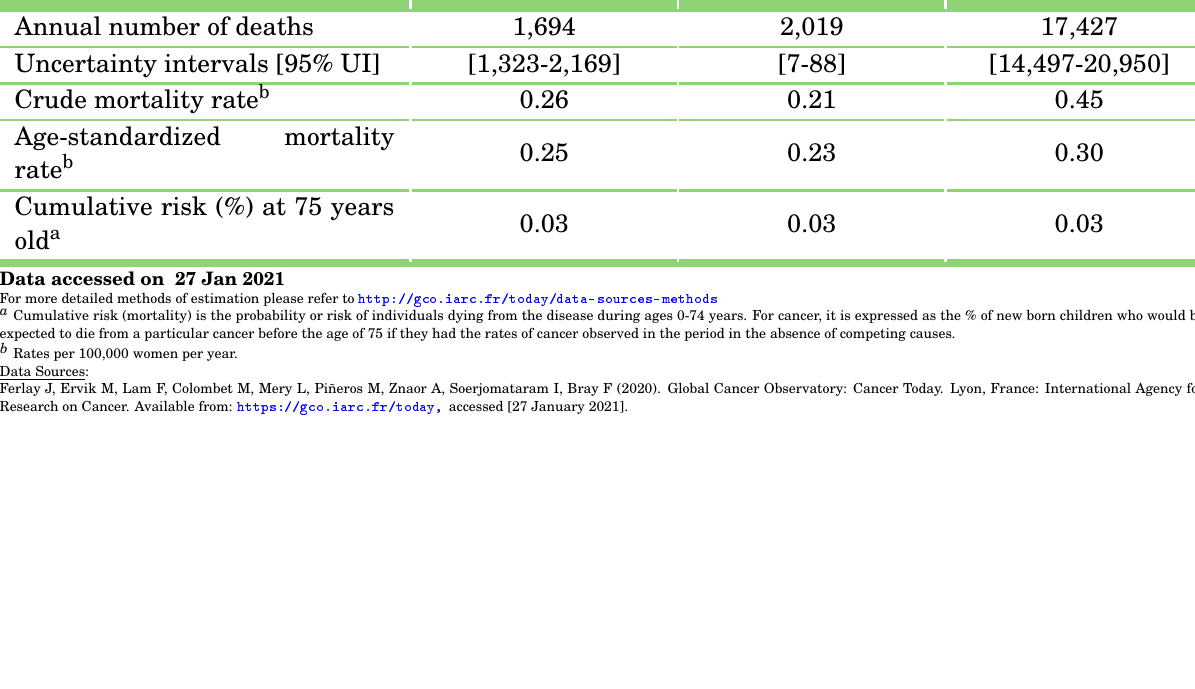
Table 10: Vulva cancer mortality in India (estimates for 2020)